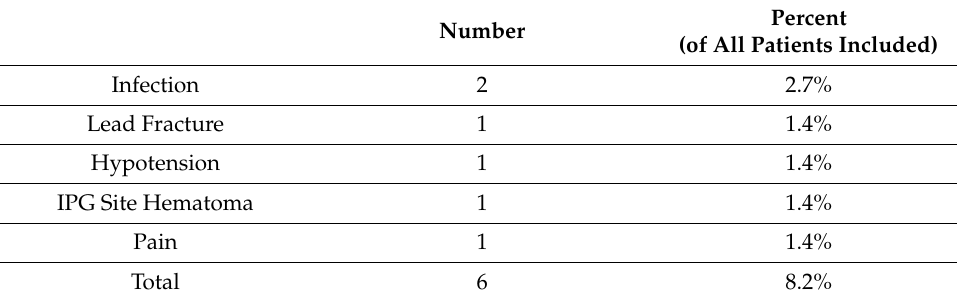
Table 2. Readmissions within 90 days of